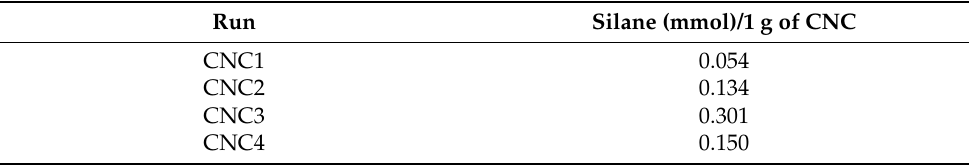
Table 4. Mmol of silane grafted on 1 g of CNC by varying the type of